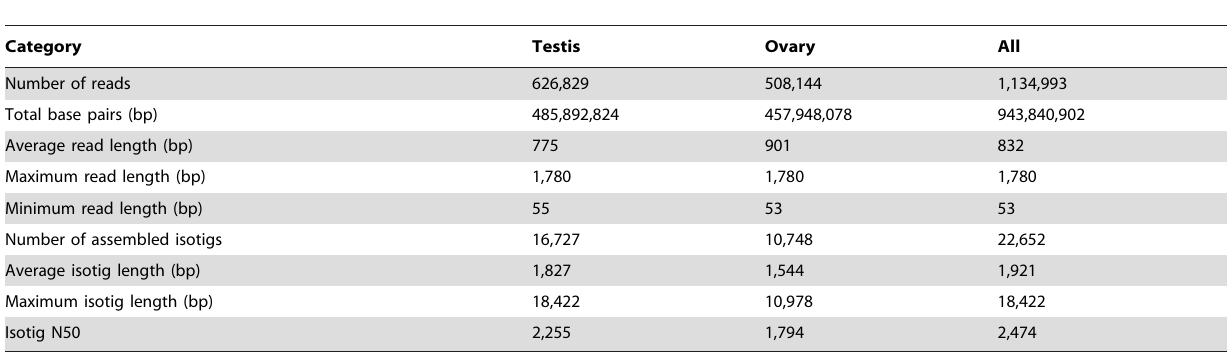
Table 1. P. clarkii transcriptome assembly